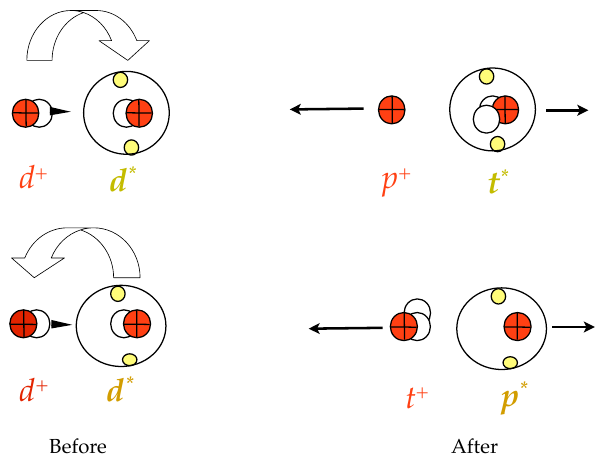
Fig. 3. An illustration of the two possible d – d ∗ neutron transfer reactions. Protons (in red), neutrons colorless, and electrons (in yel-